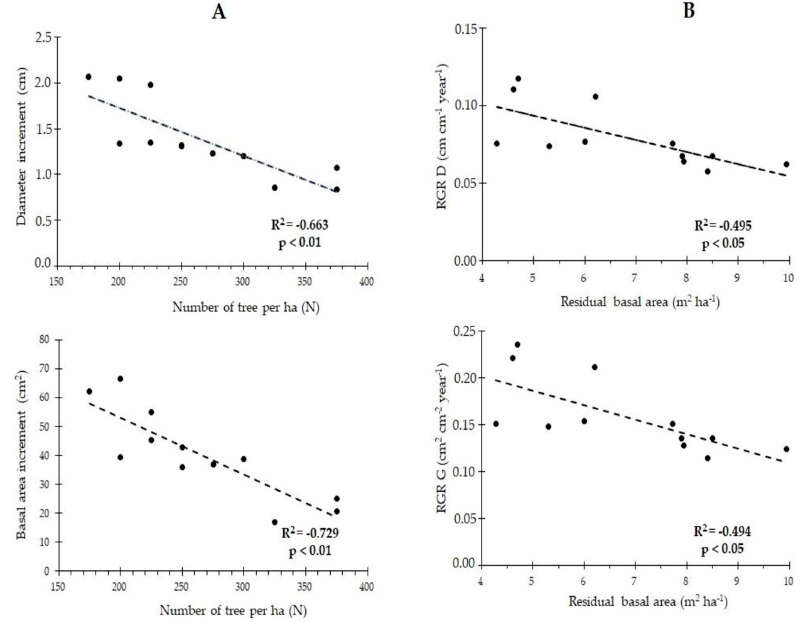
Figure 2. Coe ffi cient of determination (R 2 ) and p value for the relationship of absolute ( A ) and rela- tive ( B ) growth rate in DBH and basal area with plot density in terms of number of trees (N) and basal area (G) per ha, in traditional agroforestry systems in Ecuadorian Amazon upper basin.